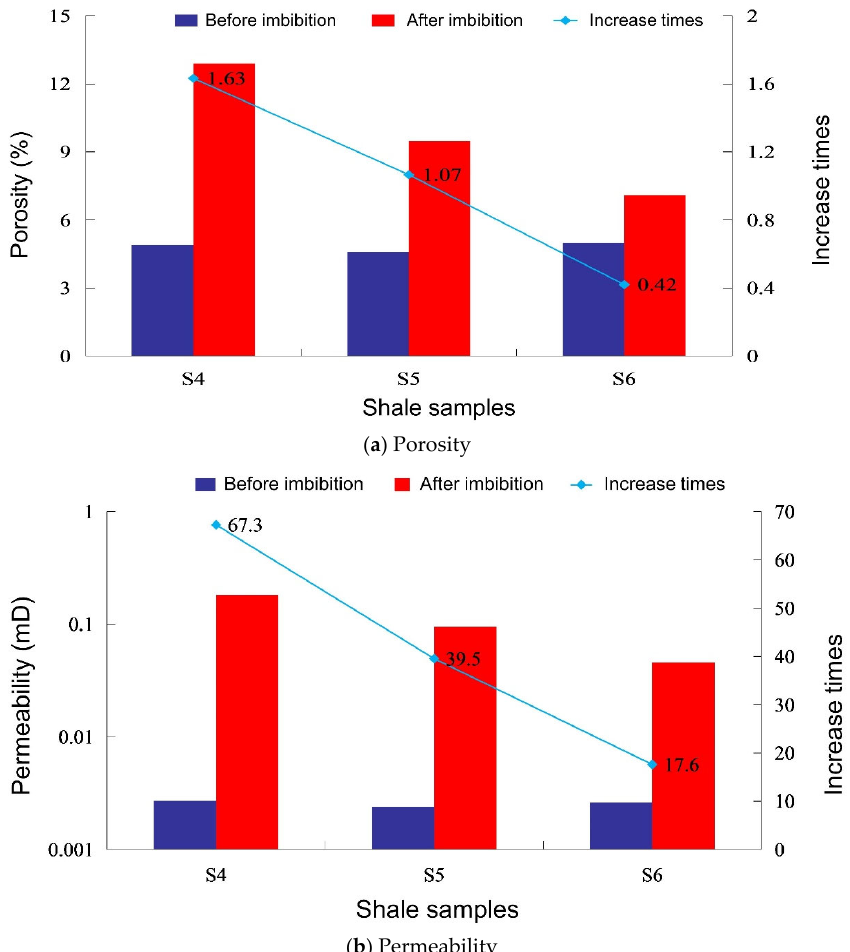
Figure 16. Comparison of porosities and permeabilities of 3 shale samples before and after imbibi ‐ tion.